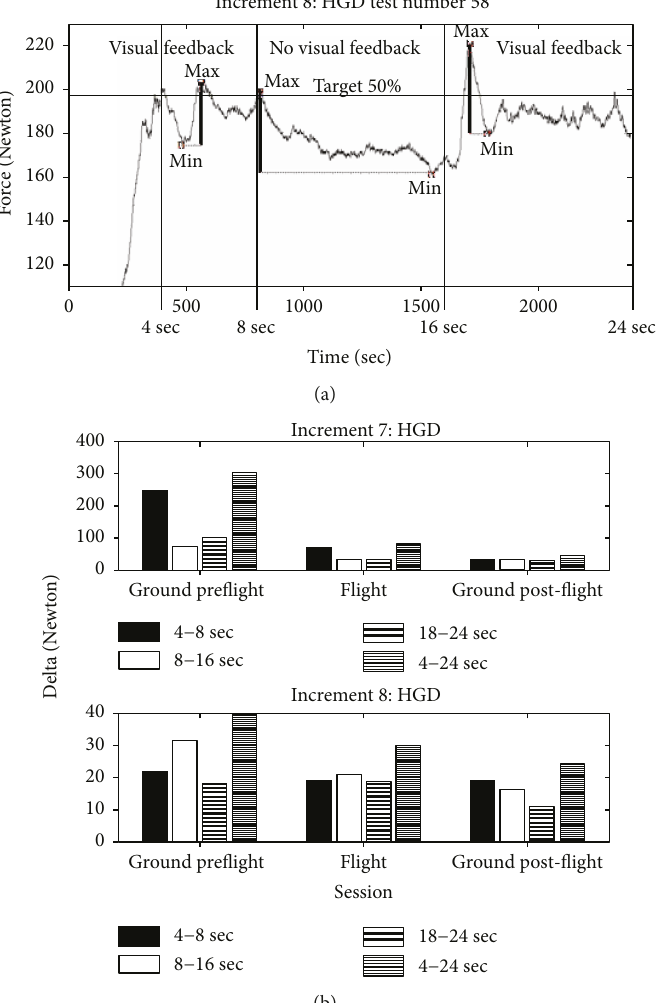
Figure 6: Maximum force range. (a) DELTA de fi nition for each time window. (b) DELTA trend for handgrip dynamometer (HGD)